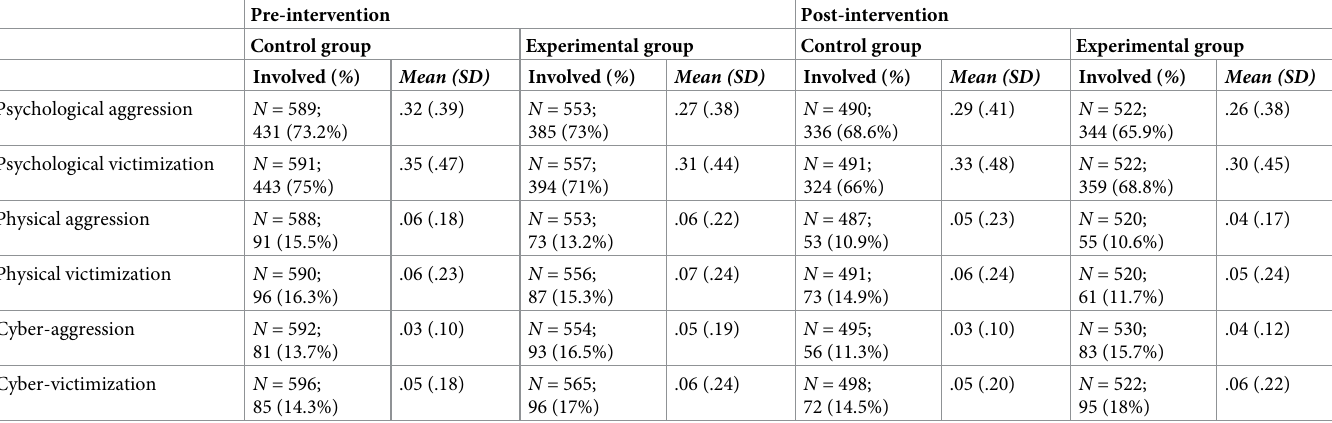
Table 5. Results of dating violence for control group and experimental group in both